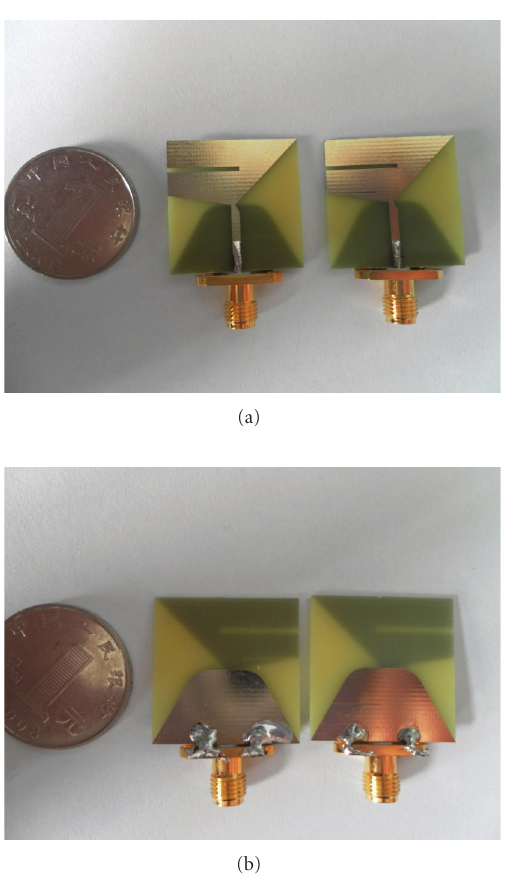
Figure 6: The photos of the proposed antenna: (a) the front of dual band-notched antennas, (b) the back of dual band-notched antennas.